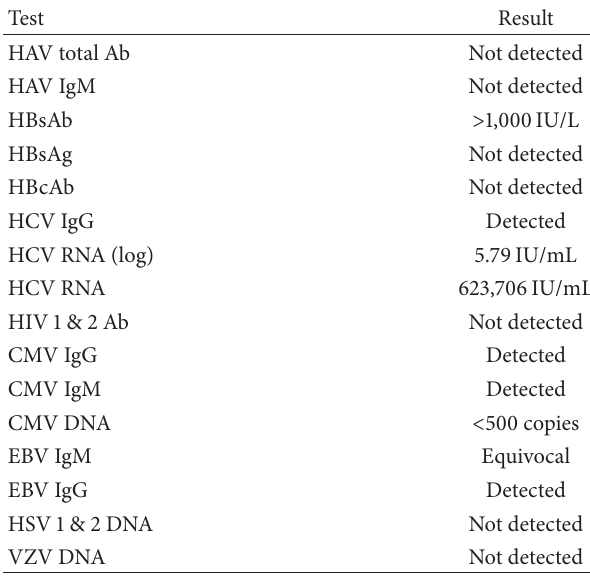
Table 2: Viral screen, positive for active hepatitis C infection.